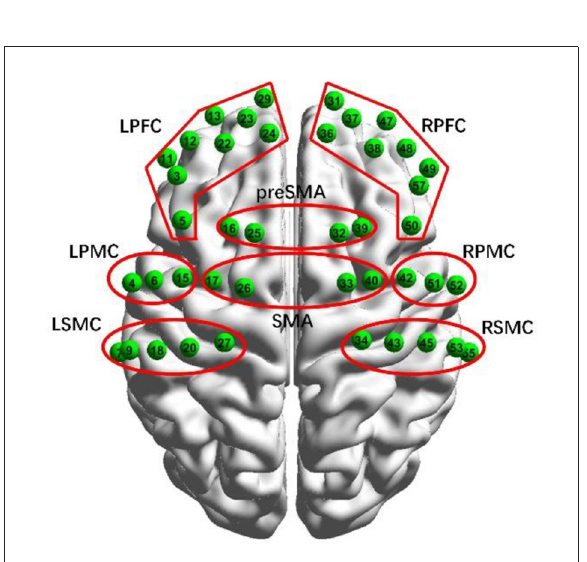
FIGURE3 Channel configuration for fNIRS